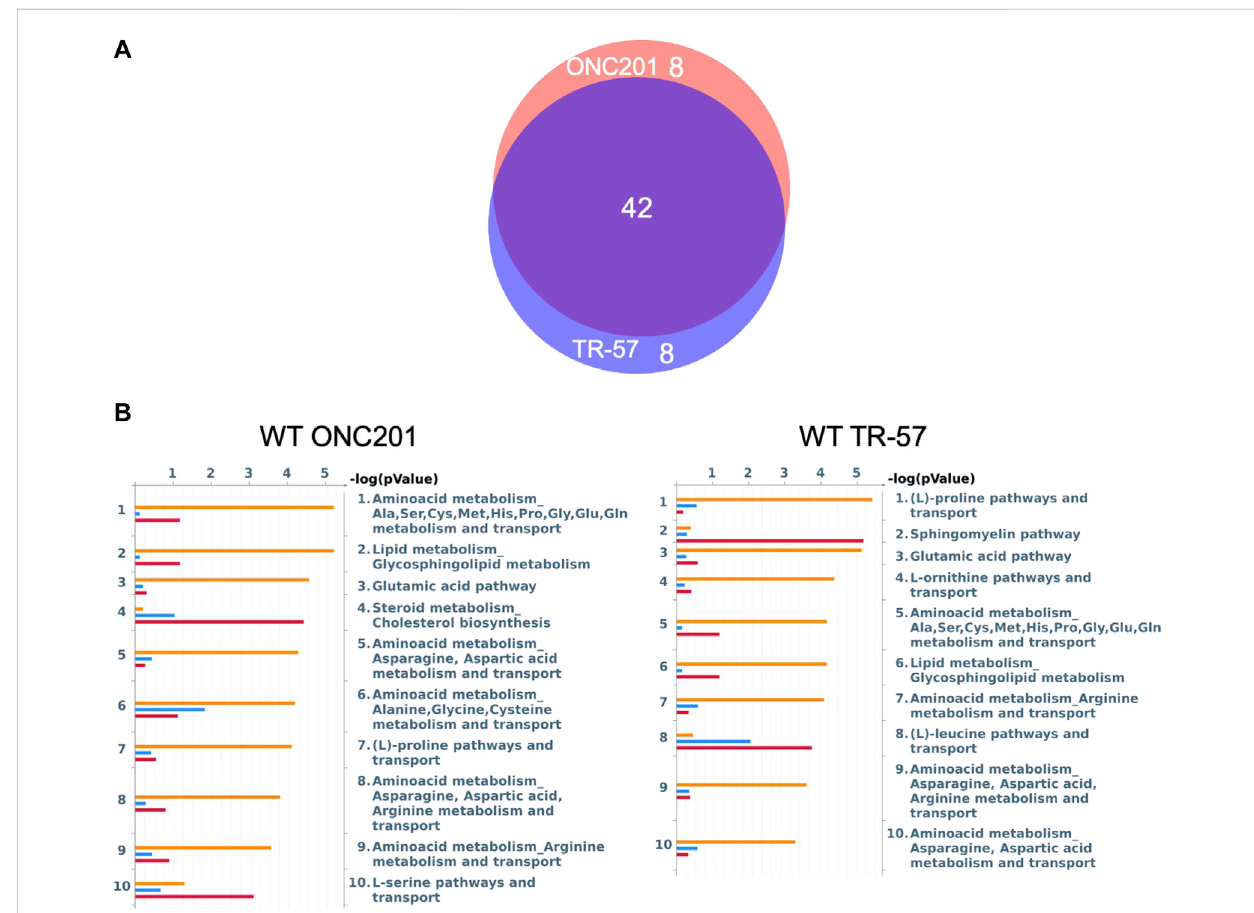
MetaCore pathway analysis reveals multiple pathways affected at the proteomic, transcriptomic, and metabolomic level with potential for further investigationintriple-negativebreastcancercells. (A) Venndiagramendogenousmetabolicnetwork(EMN)overlapbetweenONC201andTR-57treated WT SUM159 cells. Values represent number of pathways found in each group using data from Figure 2. (B) MetaCore Endogenous Metabolic Network (EMN) analysis from proteomic(blue), metabolomic (orange), and transcriptomic (red) datasets for WT SUM159 cells treated with 10 μ M ONC201 or 150 nM